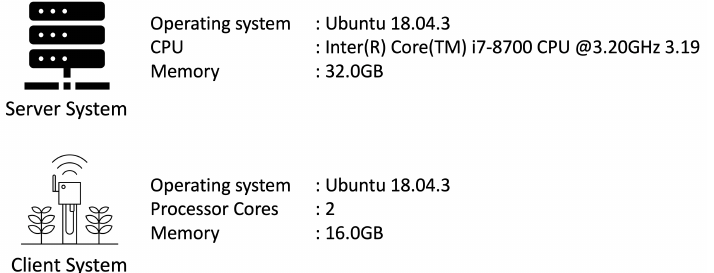
Figure 11. Experimental